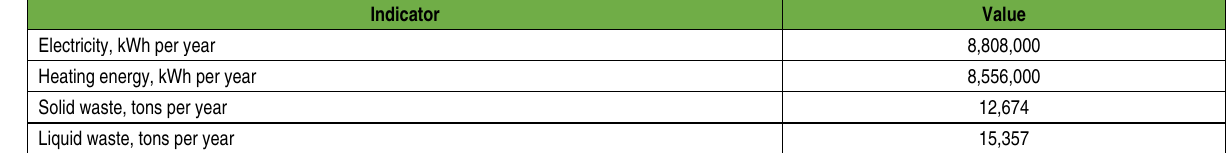
Table 7. The estimated productivity of biogas